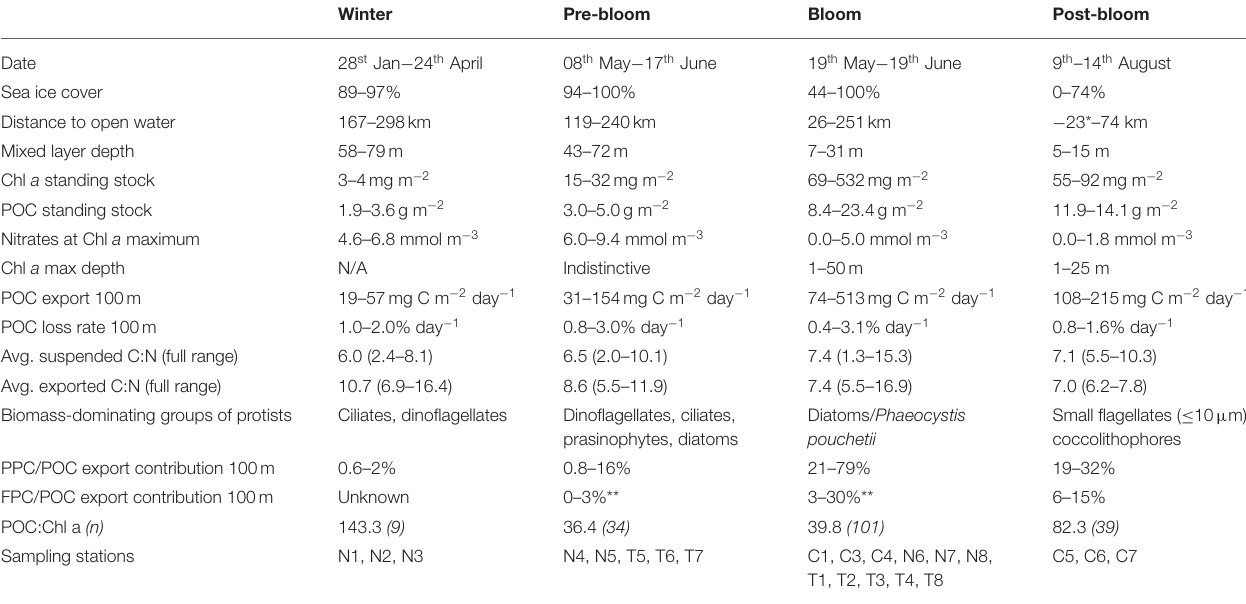
TABLE 3 | Physical and biological properties during the different bloom stages at the 22 sampling stations in 2014 and